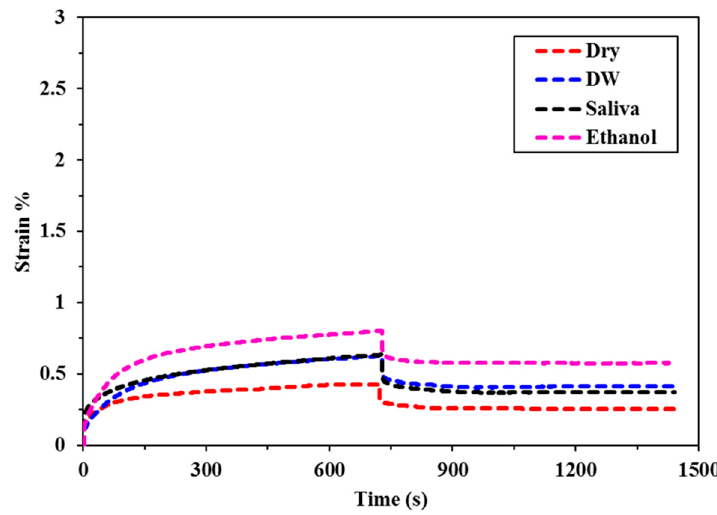
Figure 6. Creep deformation and recovery of XF in various FSOS.